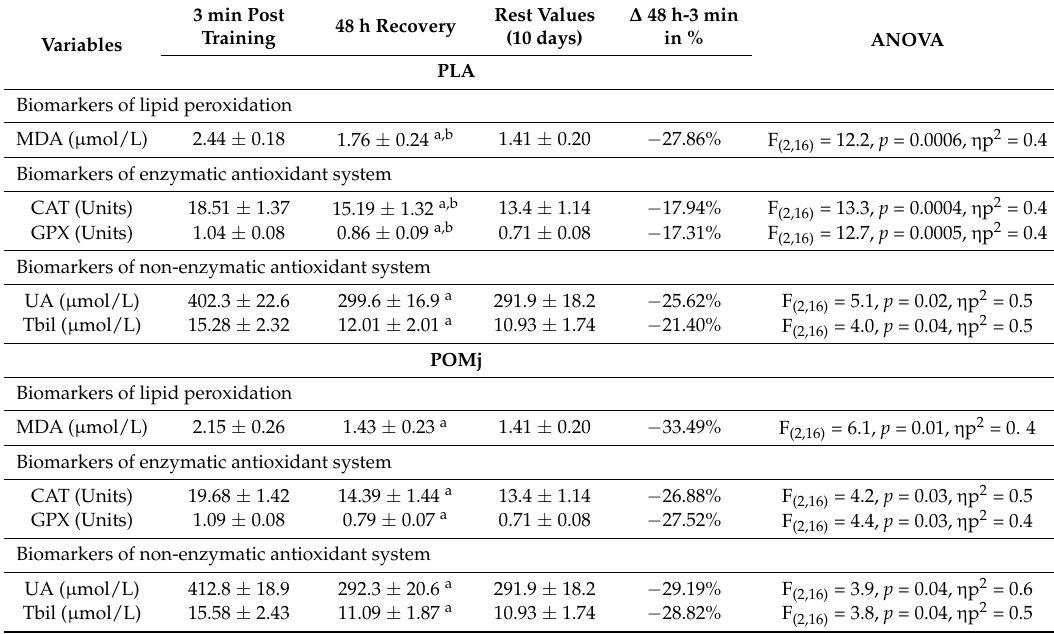
Recovery kinetics of the oxidative stress responses after placebo and pomegranate